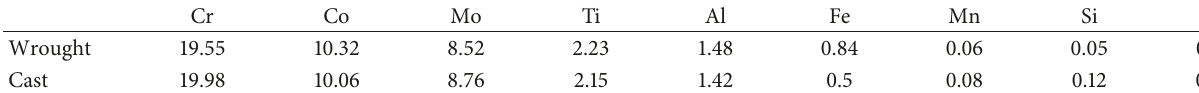
Table 1: Chemical composition (wt.%) of Haynes 282 alloy.